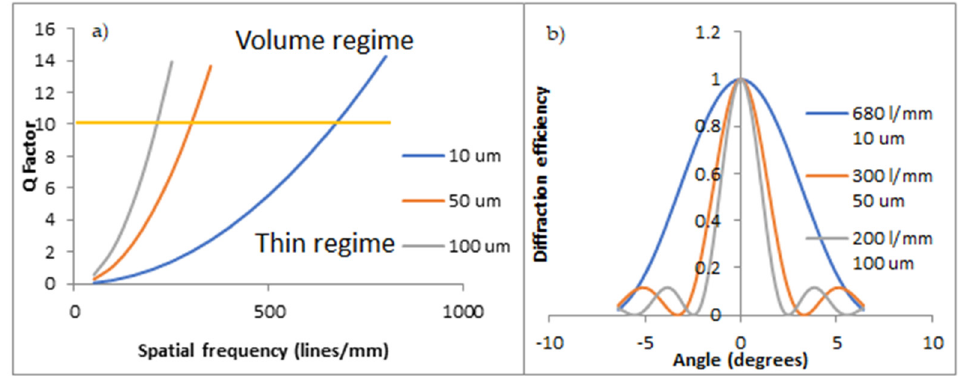
Figure 2. ( a ) Q factor at different grating thickness and spatial frequency values. ( b ) Angular selectivity curve at two different grating thicknesses and spatial frequencies with a Q factor of 10.